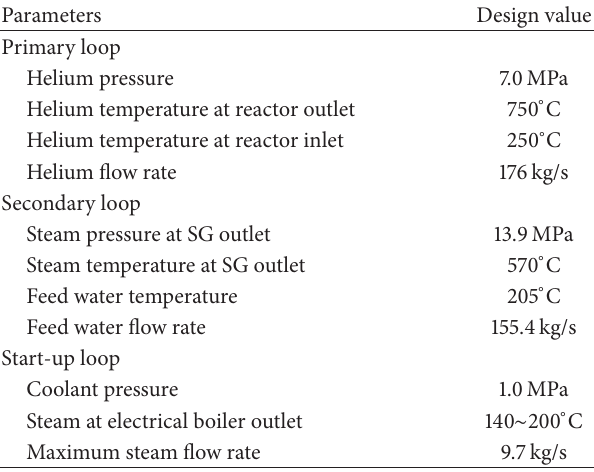
Table 1: Design parameters of HTR-PM.